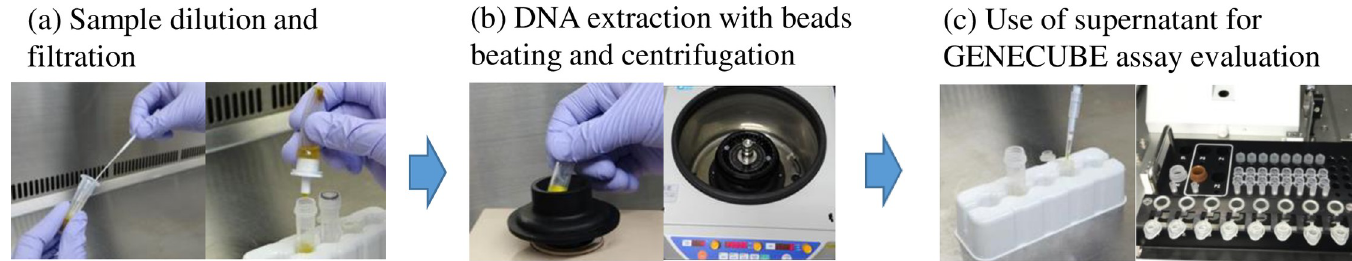
Fig 2. Preparation of test samples for the GENECUBE Clostridioides difficile assay.